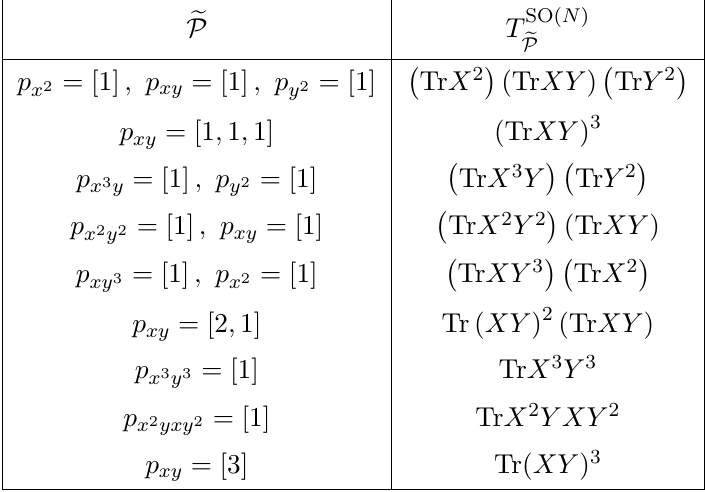
Table 6 . The 9 di(cid:11)erent SO( N ) multi-traces at n = m = 3 along with their labels. Any constituent partitions of e P that are not explicitly listed are set to